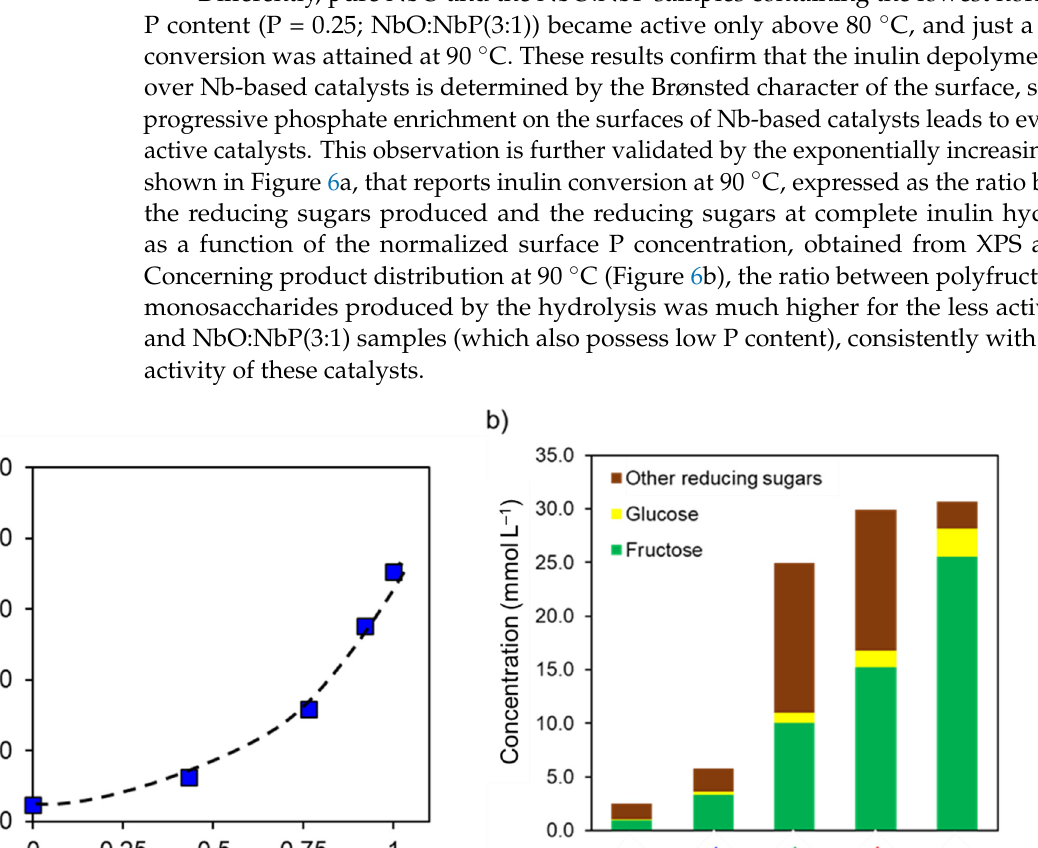
Figure 6. Catalytic performances of pure NbO and NbP and relevant mixtures in the reaction of hydrolysis of inulin evaluated at 90 °C; inulin conversion against normalized surface P concentration of samples ( a ); and distribution of the reducing sugar concentration (glucose, fructose, and polyfructans) for each sample ( b ). Table 2. Kinetic and activation parameters for the reaction catalytic hydrolysis of inulin.